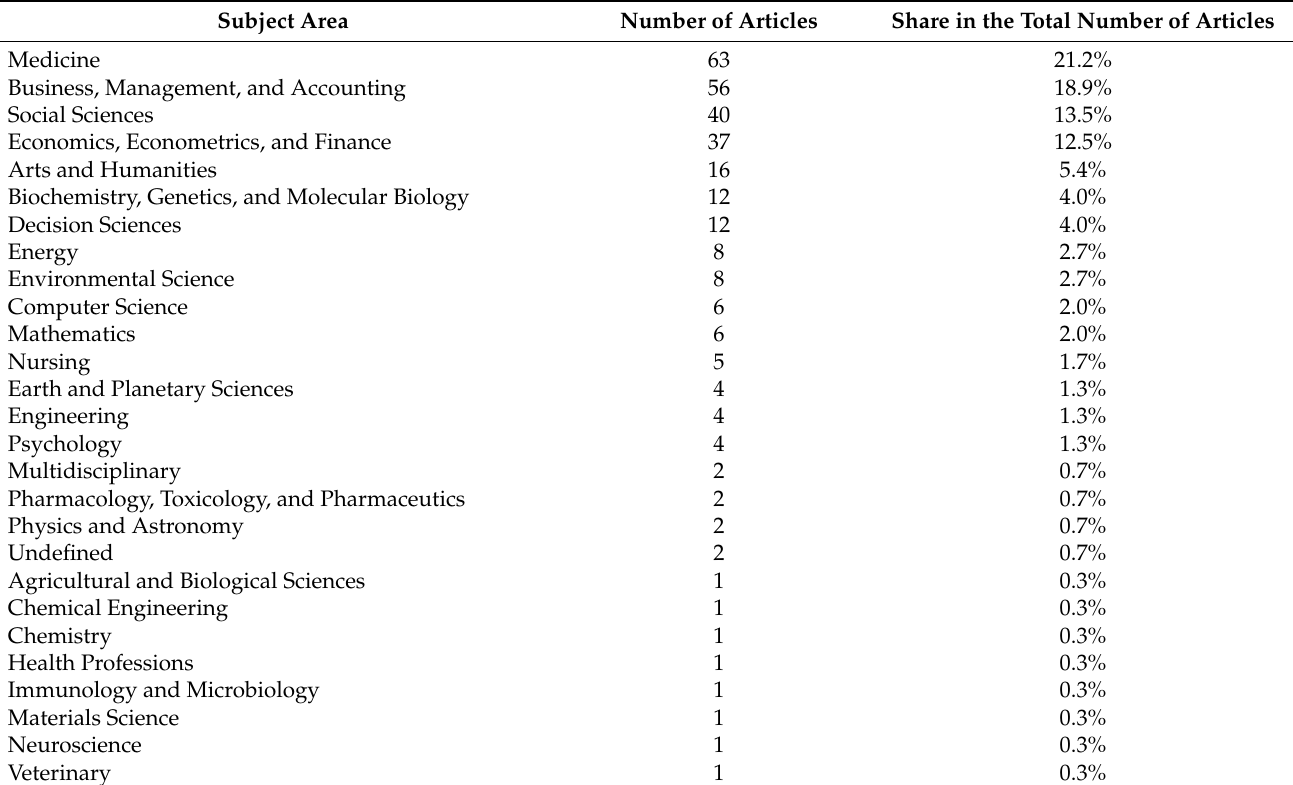
Table 5. Subject area distribution among the